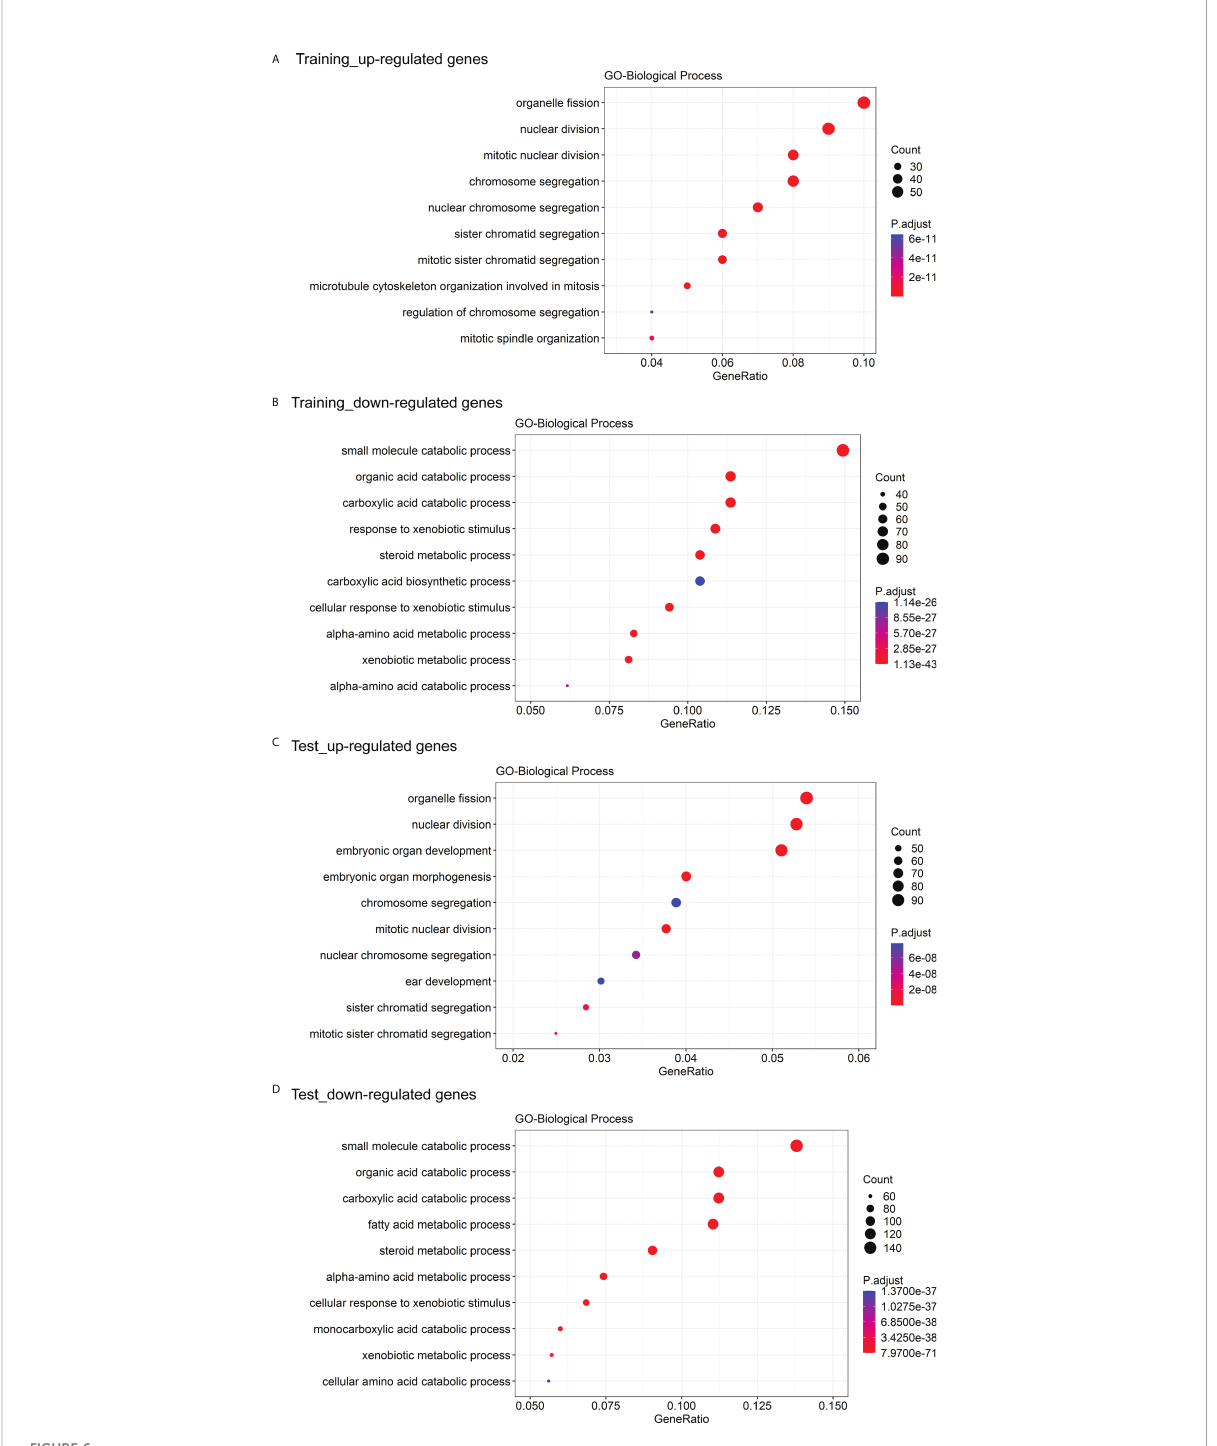
FIGURE 6 GO enrichment analysis of DEGs between the high- and low-risk groups. (A) The top 10 GO biological processes with the signi fi cant enrichment of the up-regulated genes between the high- and low-risk groups in the training cohort. (B) The top 10 GO biological processes with the signi fi cant enrichment of the down-regulated genes between the high- and low-risk groups in the training cohort. (C) The top 10 GO biological processes with the signi fi cant enrichment of the down-regulated genes between the high- and low-risk groups in the test cohort. (D) The top 10 GO biological processes with the signi fi cant enrichment of the down-regulated genes between the high- and low-risk groups in the test